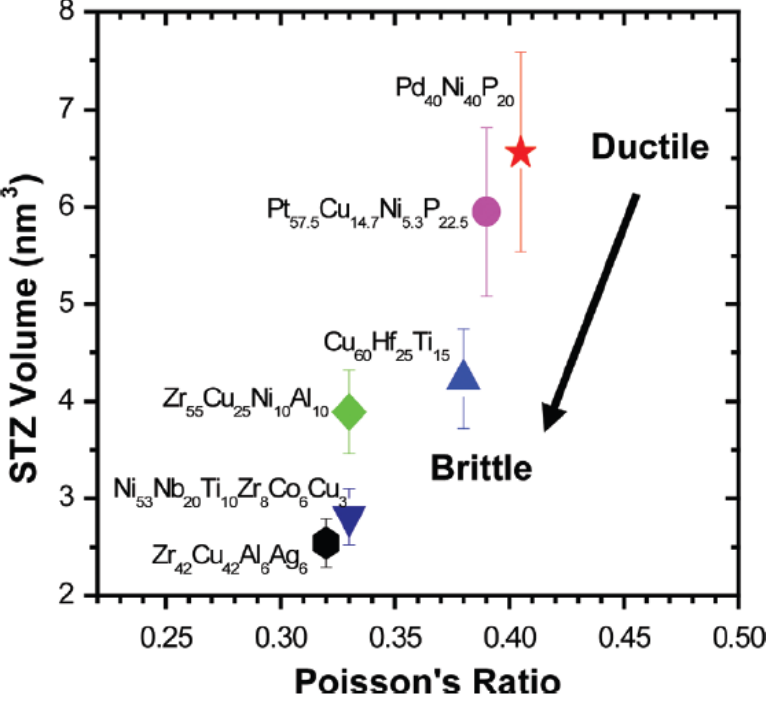
Figure 9. Correlation of shear transformation zone (STZ) volume with Poisson’s ratio. The tougher glasses tend to have larger STZ volume and Poisson’s ratio. Reprinted from [88], with permission from Proceedings of the National Academy of Sciences PNAS. Copyright (2008) National Academy of Sciences (Washington, DC,